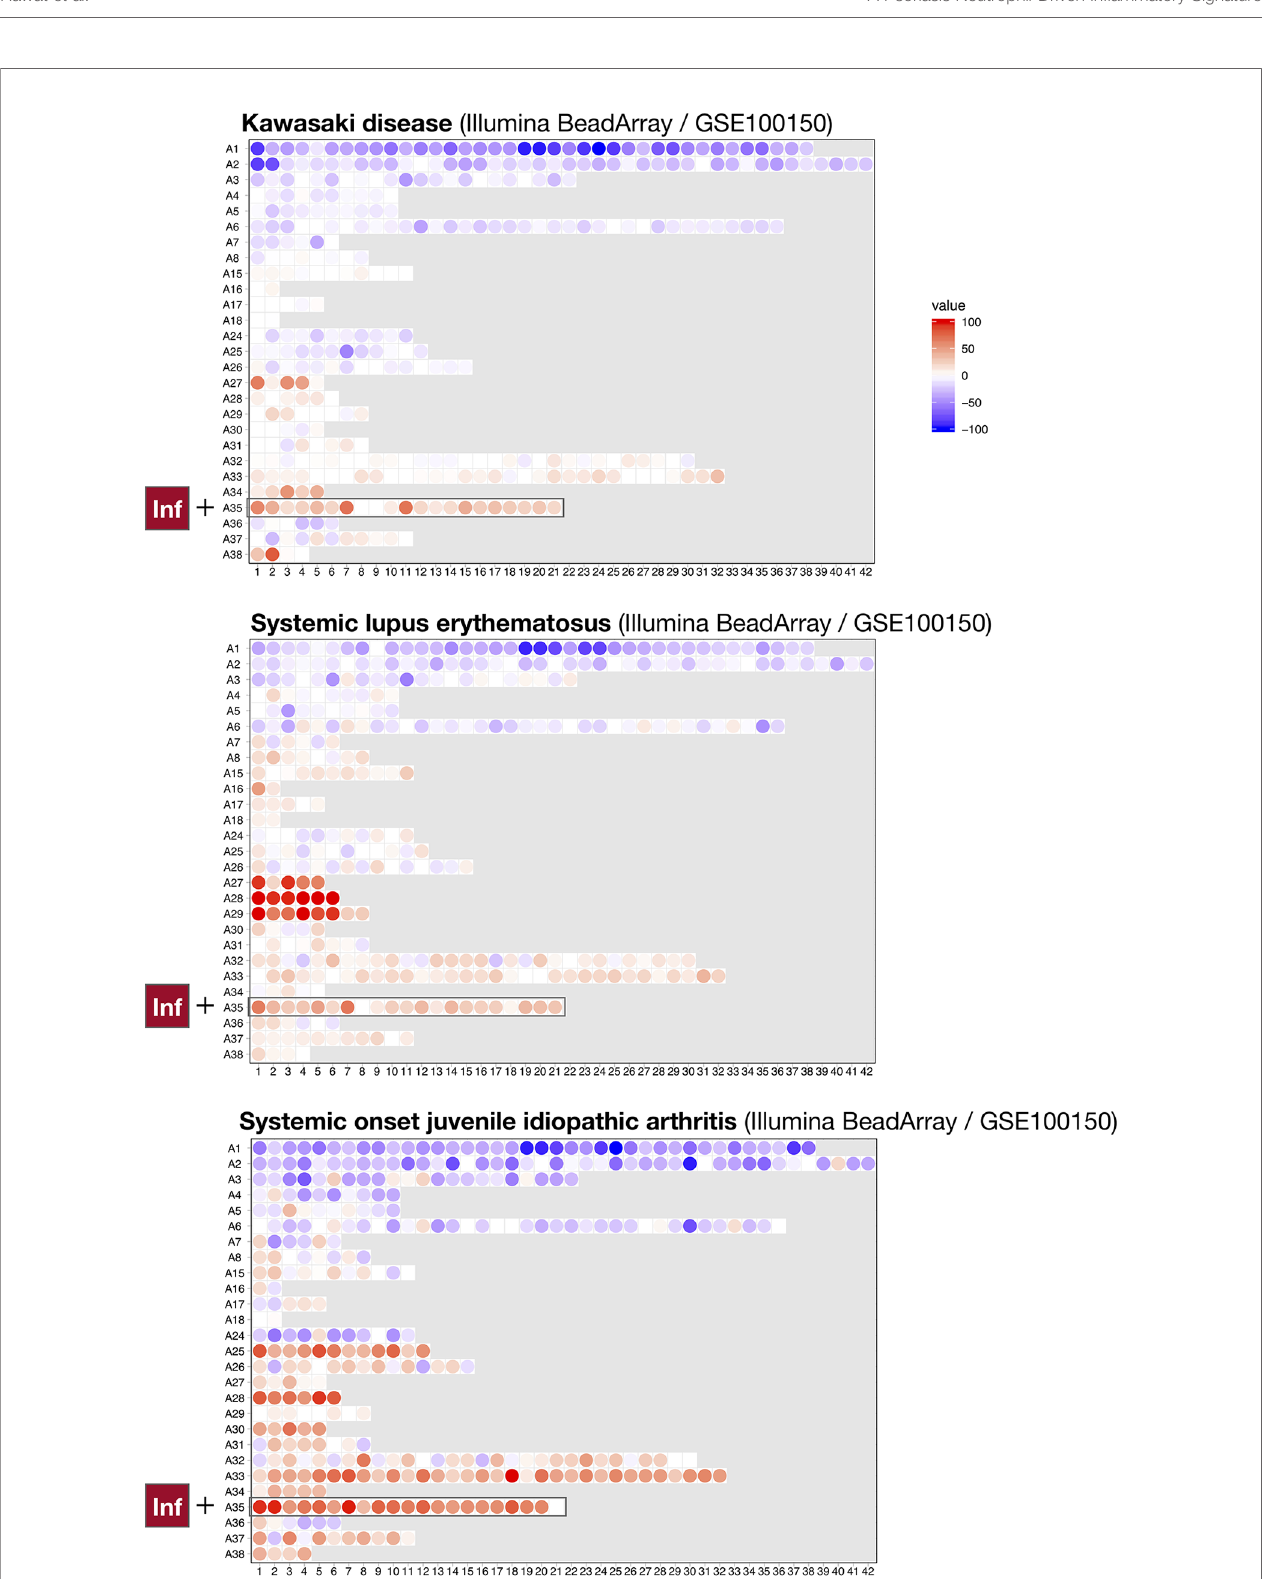
FIGURE 4 | Blood transcriptional fi ngerprints of other autoimmune or autoin fl ammatory diseases. The differences in the levels of transcript abundance in the blood of patients with Kawasaki disease (top), systemic lupus erythematous (middle), or systemic onset juvenile idiopathic arthritis (bottom) are mapped on a grid, as described in Figure 1 . The modules belonging to aggregate A35 are highlighted on this